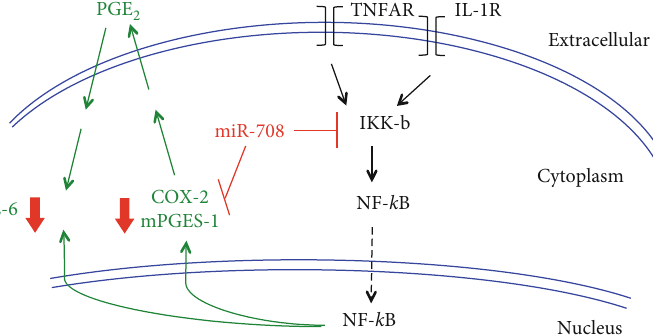
Figure 7: Proposed model of miR-708-mediated negative regulation of TNF α /IL-1 β signaling in diseased lung cells. Model representing the repressive e ff ects of miR-708 on TNF α /IL-1 β -mediated regulation of arachidonic acid and IL-6 signaling in A549 cells. Black arrows represent activated signaling pathways, while black dotted lines represent miR-708-inhibited signaling cascades. Green lettering and arrows indicate AA signaling, and red lines represent miR-708 target